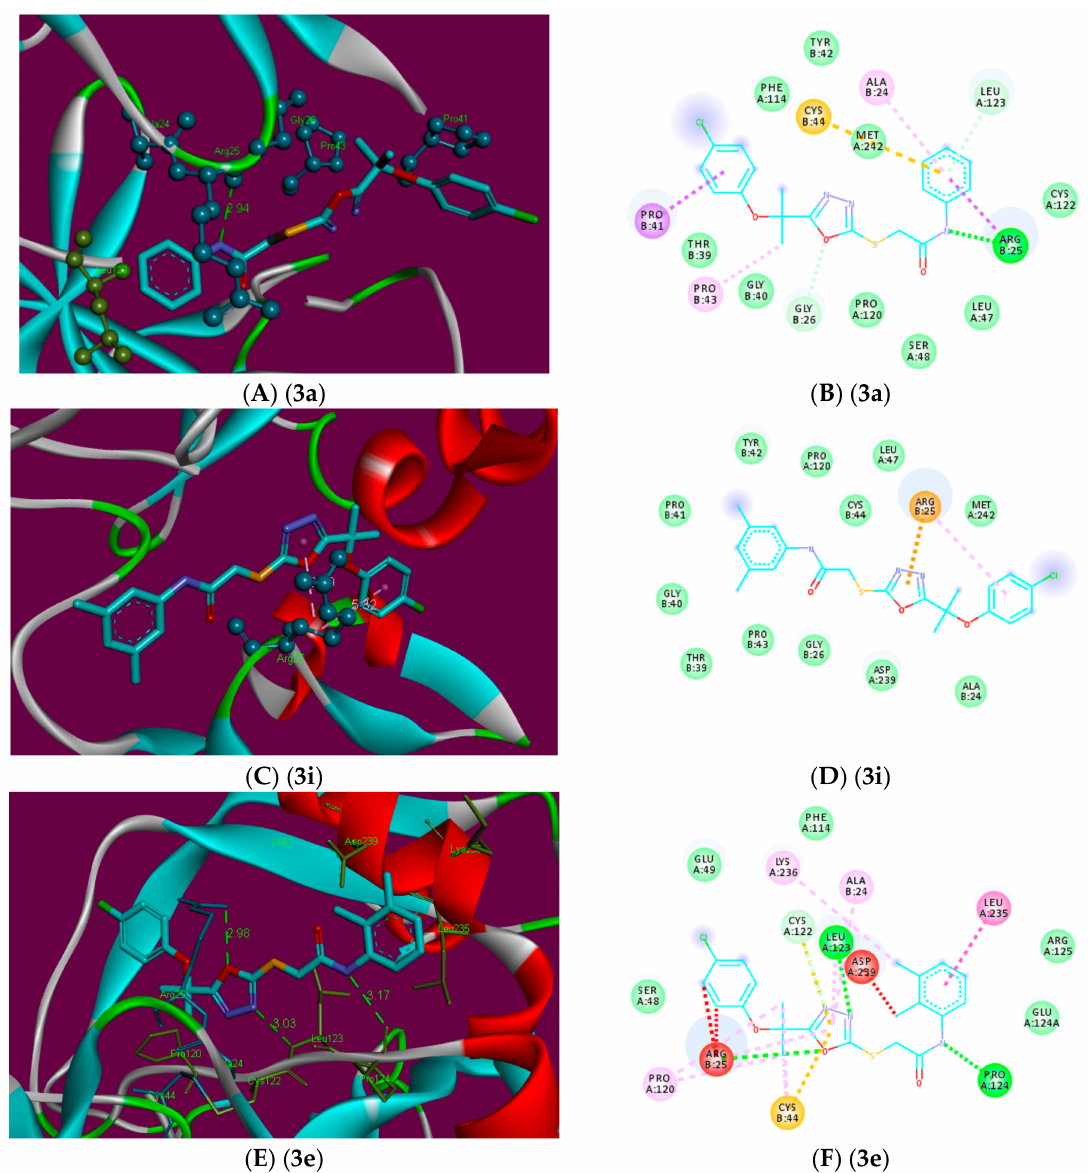
Figure 5. 2D ( B , D , F ) and 3D ( A , C , E ) binding site interactions of the most probable docked ligands 3a , 3i , and 3e within F-Xa active site showing their binding interactions with Patch Dock, depicting unfavorable bump (red), carbon hydrogen bond (light green), pi-alkyl (light pink), pi-cation (brown), and amide pi-stack (pink)